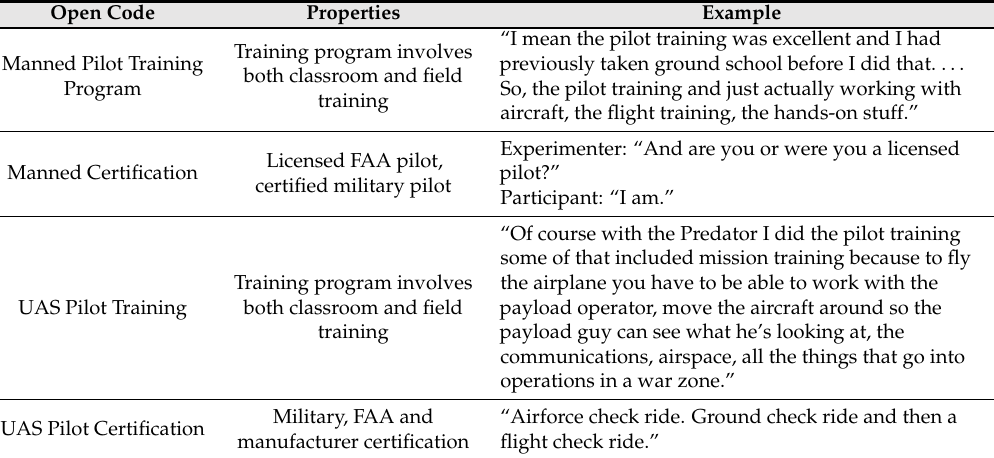
Table A2. Research Question: What types of training and certification did participants receive prior to engaging in aviation